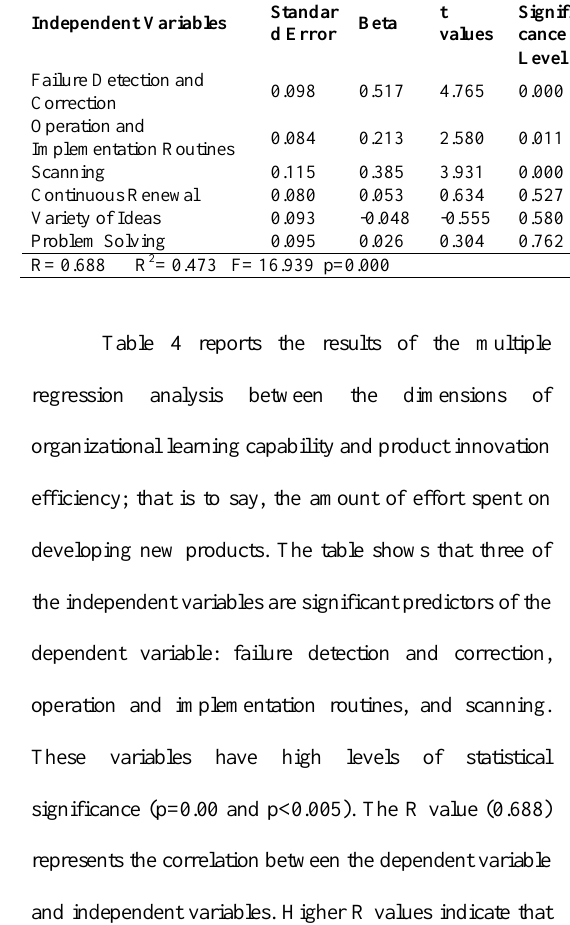
Table 4: Results of the Multiple Regression Analysis between Dimensions of Organizational Learning Capability and Innovation Efficiency Independent Variables